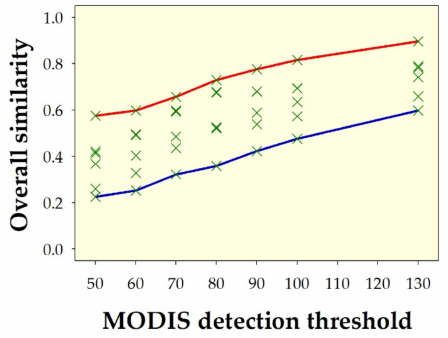
Figure 25. Overall similarity (i.e., the average of θ and δ similarities) of the temporal pattern between deforestation hotspots in Indonesia in 2020 derived from Landsat-8 OLI (at clarity ≥ 50% and deforestation intensity ≥ 50%) and deforestation hotspots in Indonesia in 2020 derived from MODIS (at change-detection thresholds ranging from 50 to 130), after interpolation at a time slice of 1 day. Green crosses indicate overall similarity (i.e., the average of θ and δ similarities) from all nine metrics. Red lines on the upper edge of the envelopes indicate the overall similarity using the Fidelity metric. Blue lines on the lower edge of the envelopes indicate the overall similarity using the metric of